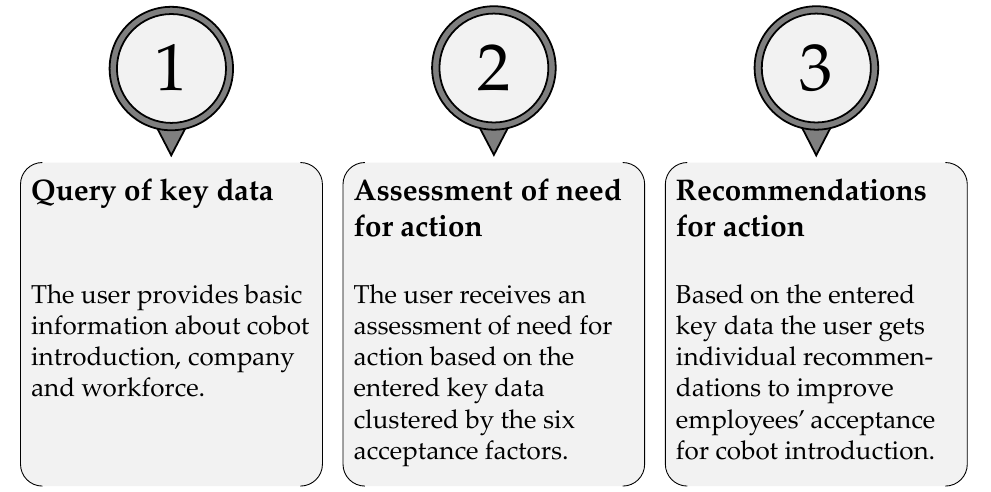
Figure 1. Process flow of the employee acceptance tool.